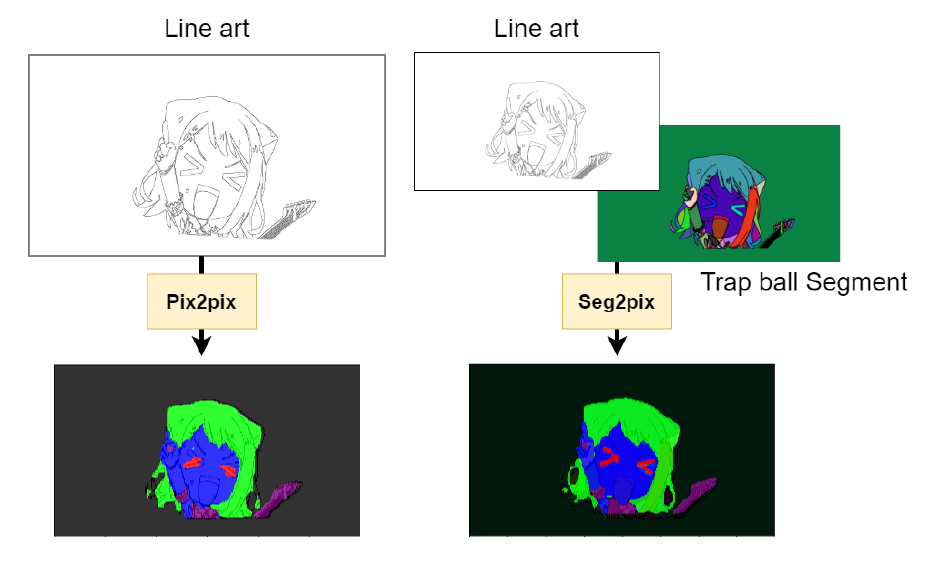
Figure 6. Image-to-image translation GAN output from only line art input (via pix2pix) and two inputs with the trap ball segmented image (via Seg2pix) showing different results in the detailed area, such as eyes and